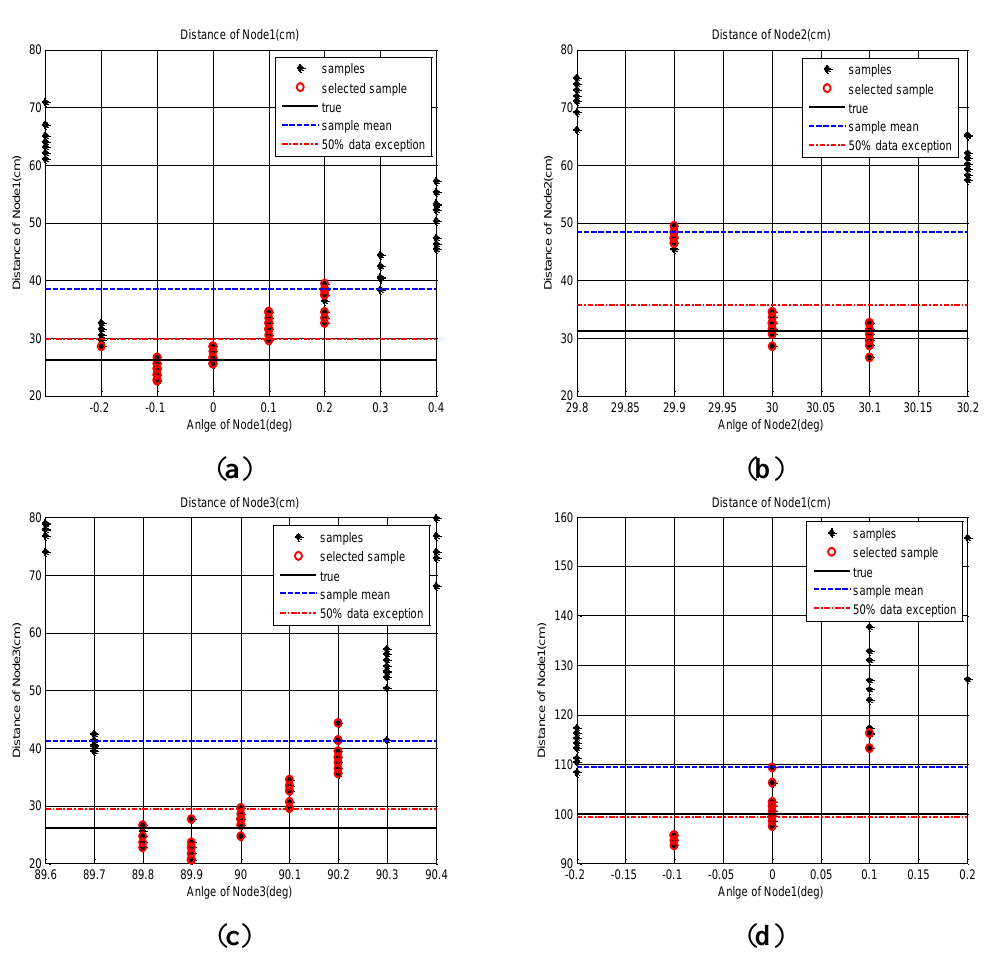
Figure 10. The performance comparison of the sensor node position estimation between the sample mean method and the 50% outlier exclusion method. ( a ) Node 1: (26 cm, 0 deg), ( b ) Node 2: (31.17 cm, 30 deg), ( c ) Node 3: (26 cm, 90 deg), ( d ) Node 1: (100 cm, 0